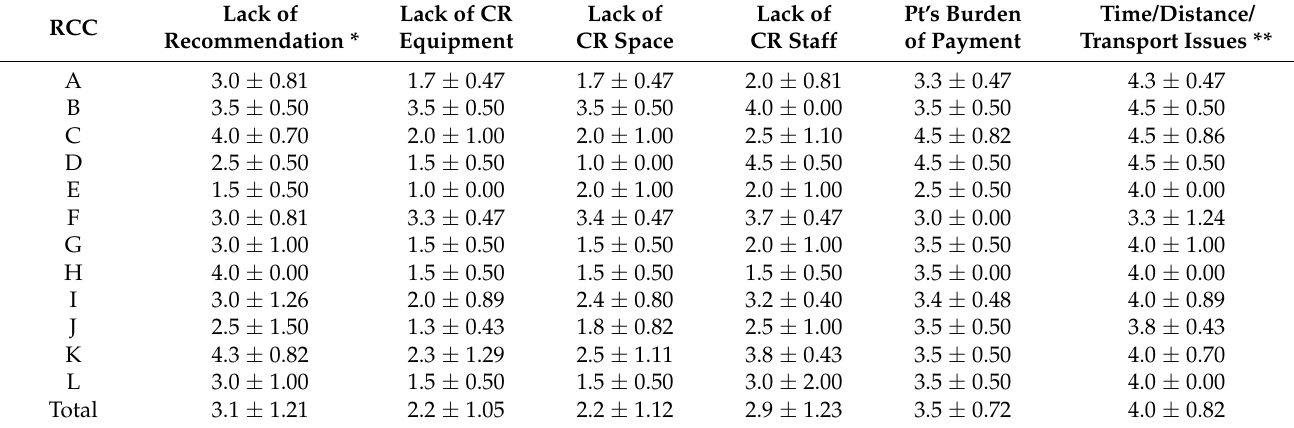
Table 9. Likert Scales of the Physician’s Opinion on Outpatient CR Barriers in 12